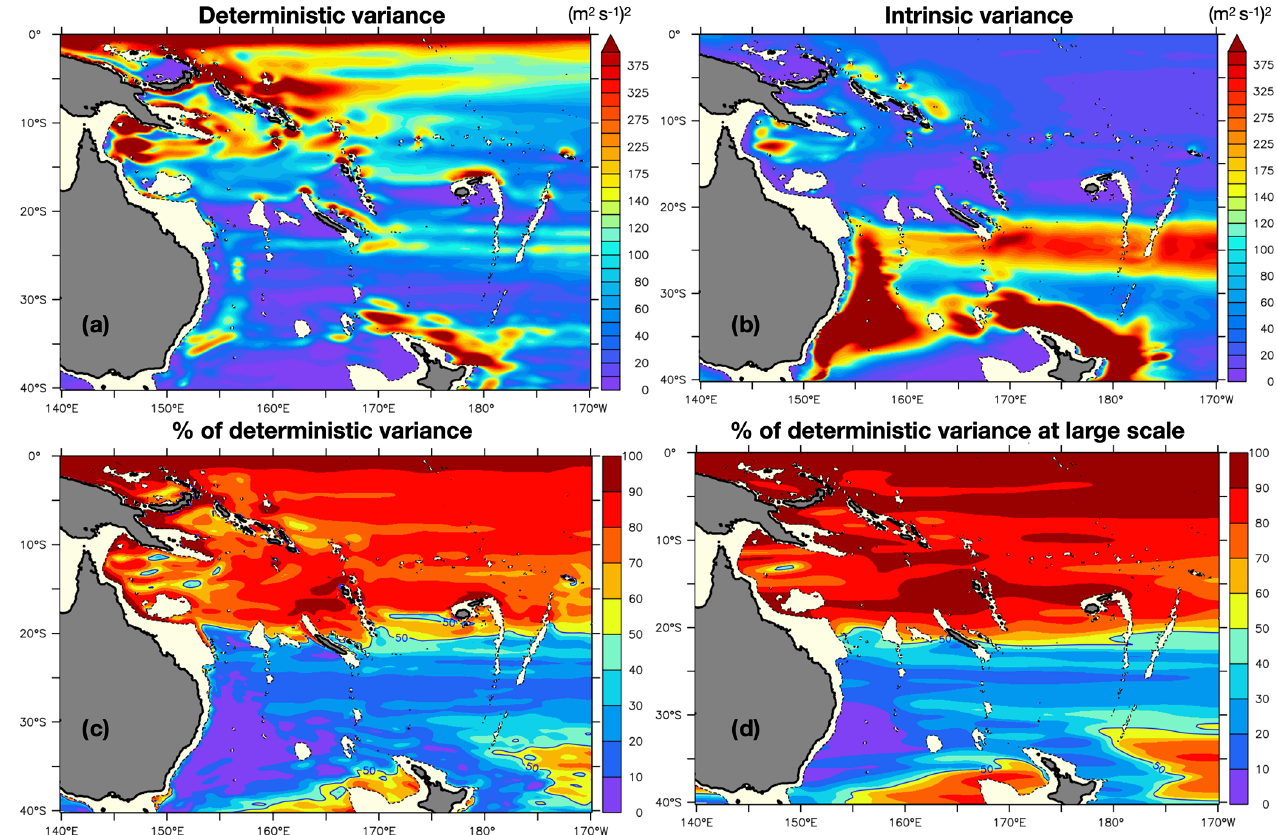
Figure 3. (a) Deterministic interannual variance: 1980–2015 variance of ensemble mean low-pass-filtered 0–1000m zonal transport. (b) In- trinsic interannual variance: ensemble mean of the squared deviation of the low-pass-filtered 0–1000m zonal transport in each member from the ensemble mean. (c) Ratio R LF of the deterministic variance to the total variance, given as a percentage. (d) Same as (c) , but for transports first spatially smoothed in each